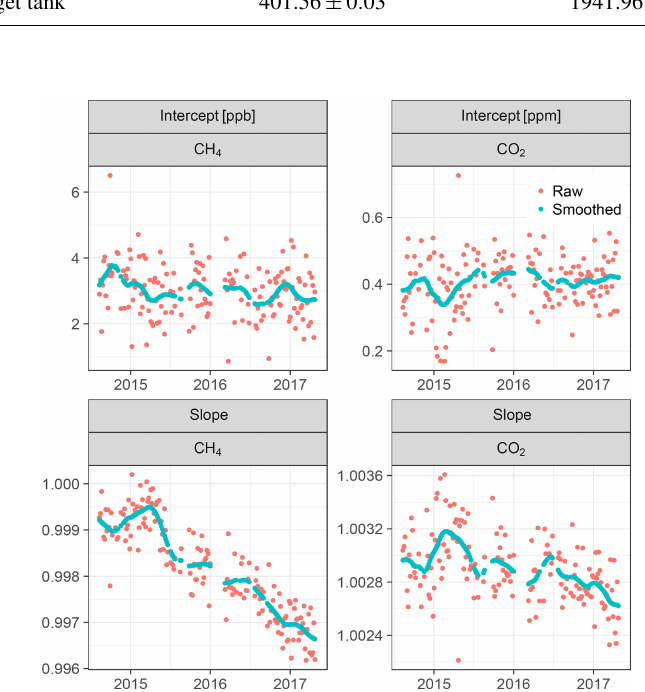
Figure C1. Coefficients of linear fits to the high, middle, and low tanks. The smoothed coefficients are used for calibrating